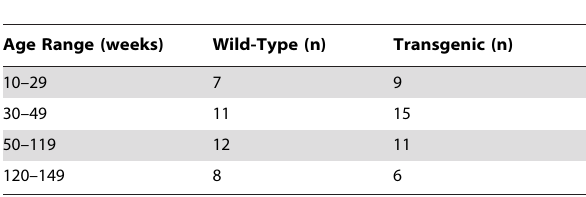
Table 1. Timepoints of phenotype